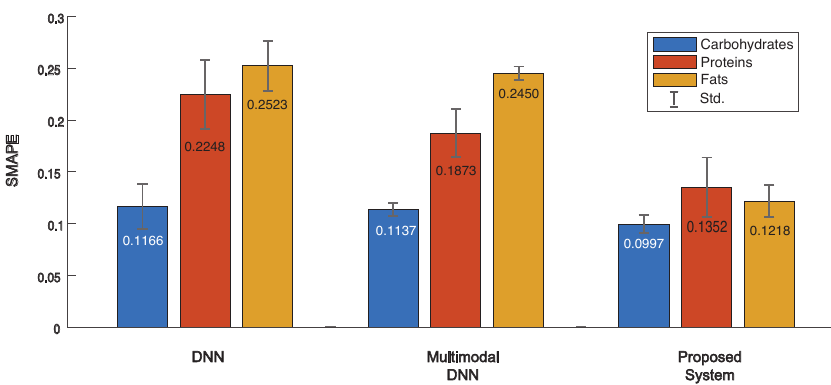
Figure 5. Evaluation of symmetric mean absolute percentage errors (SMAPE) in 3 systems to estimate food